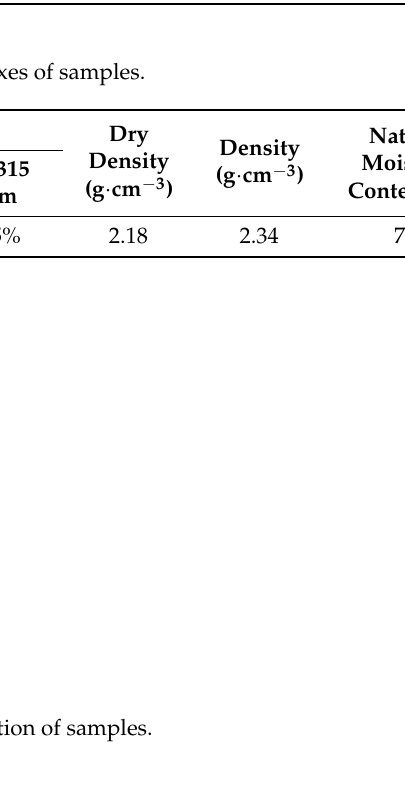
Table 1. Main components of soil particles.